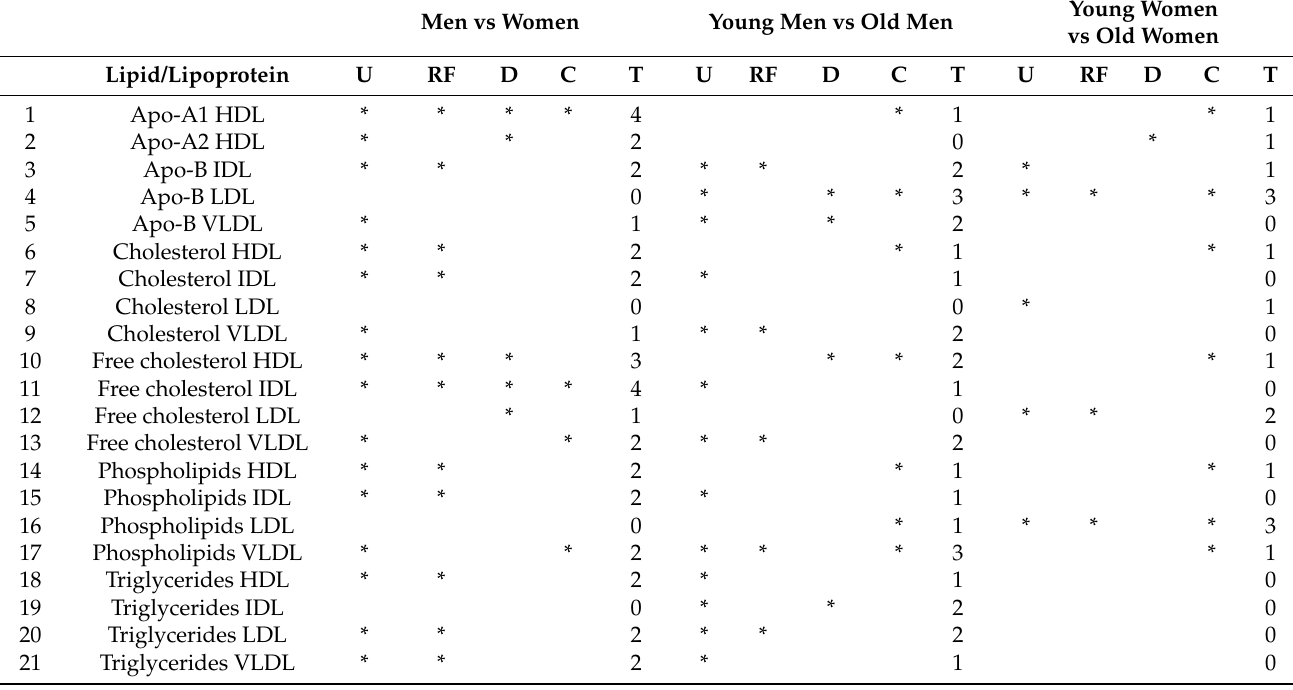
Table 7. Summary overview of the results of the integrated analysis performed: U, univariate analysis of lipid and lipoprotein concentration using Mann–Whitney–Wilcoxon test (see Table 2); RF, Random Forest predictive modeling (see Table 6 and Figure 3); Differential connectivity analysis (see Figure 7); C, Covariance simultaneous component analysis (see Figure 5); T, concordance among the analysis. * indicates a statistically significant or relevant